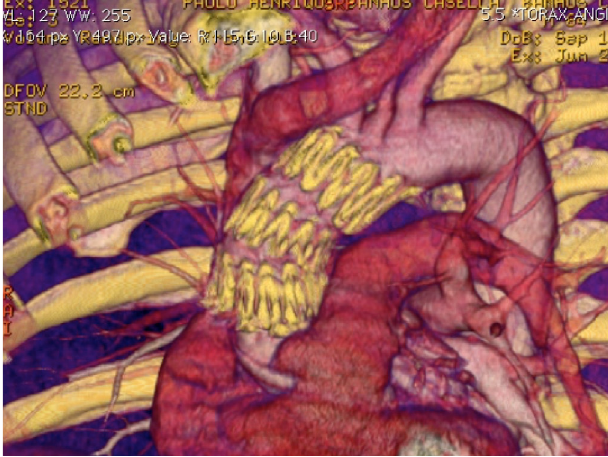
Fig. 4 – Three-dimensional computed tomography post stent graft in ascending aorta.